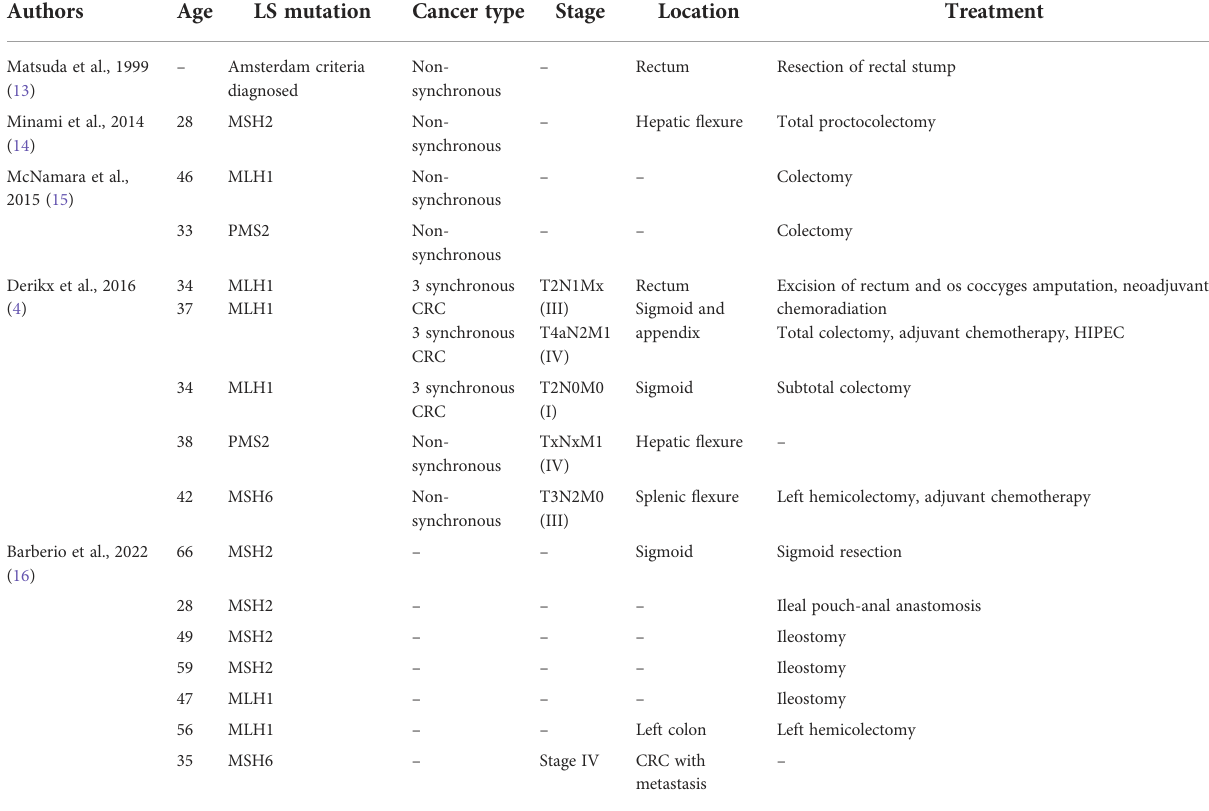
TABLE 1 Literature review of CRC in patients with concurrent IBD and LS (Lynch syndrome).